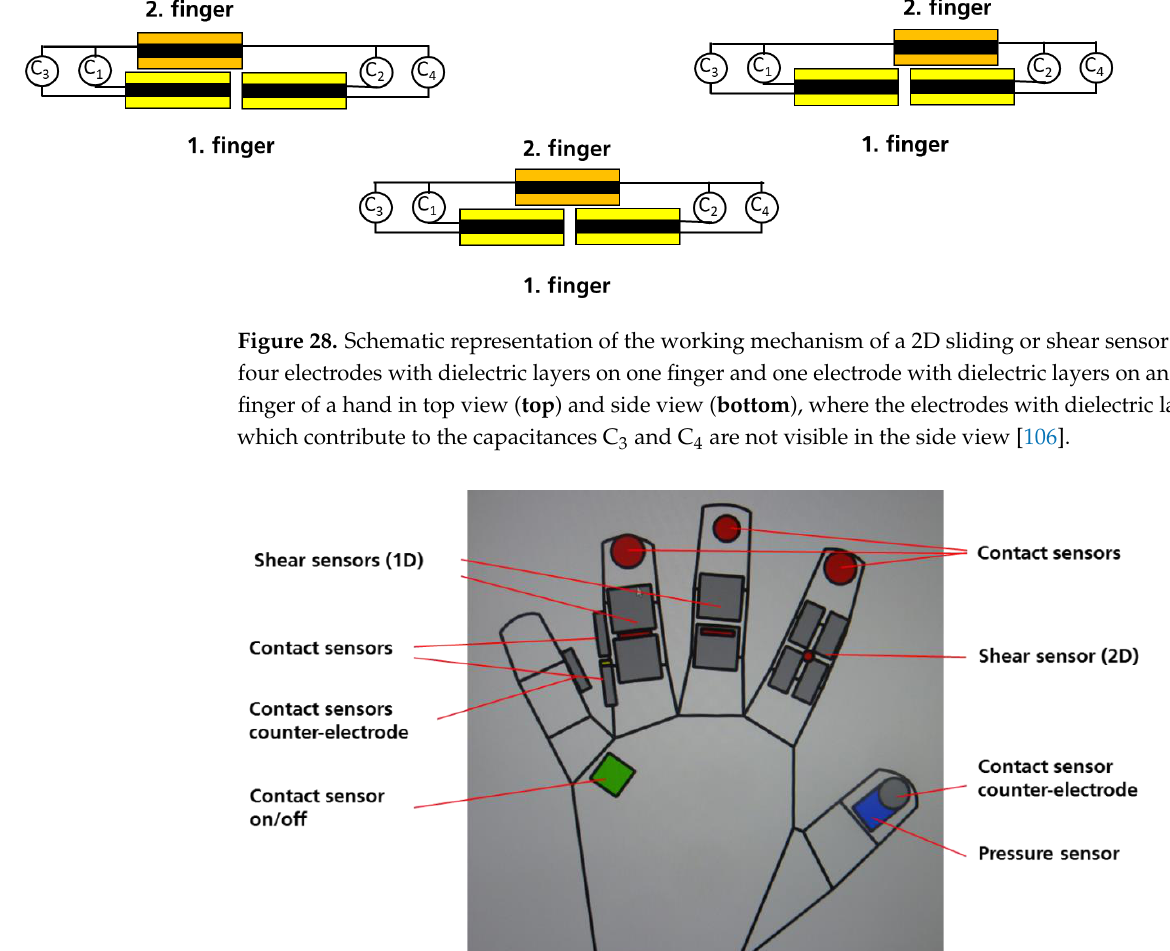
Figure 28. Schematic representation of the working mechanism of a 2D sliding or shear sensor with four electrodes with dielectric layers on one finger and one electrode with dielectric layers on an- other finger of a hand in top view ( top ) and side view ( bottom ), where the electrodes with dielectric layers, which contribute to the capacitances C 3 and C 4 are not visible in the side view [106].